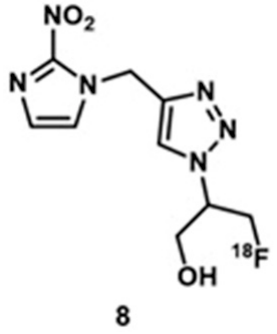
Figure 13. Chemical structure of 8 .